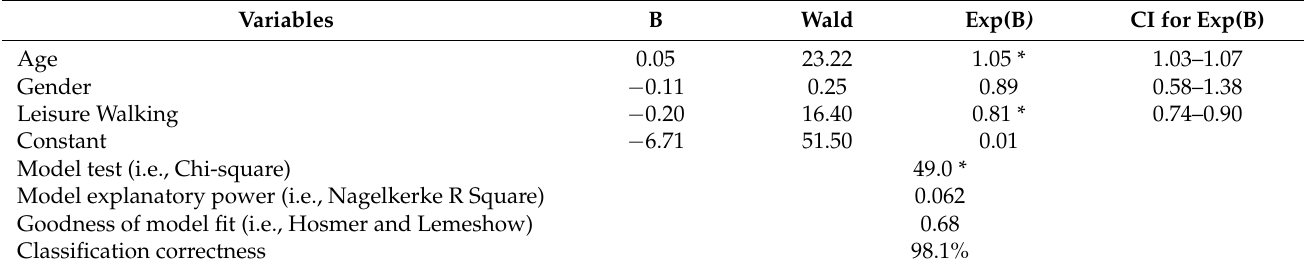
Table 4. Hierarchical logit regression for